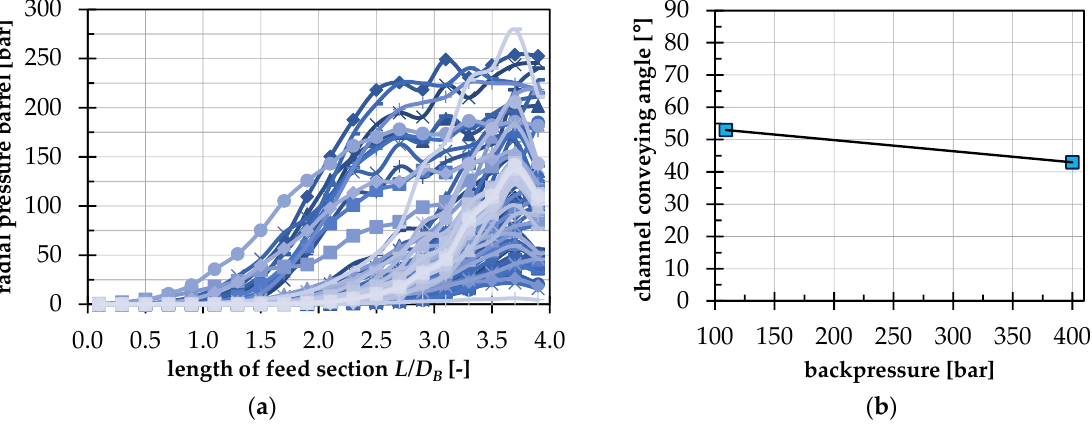
Figure 6. ( a ) Pressure curve on the barrel for all 90 test points; ( b ) influence of the backpressure on the conveying angle as an effect diagram from the analysis of variance with Design Expert.